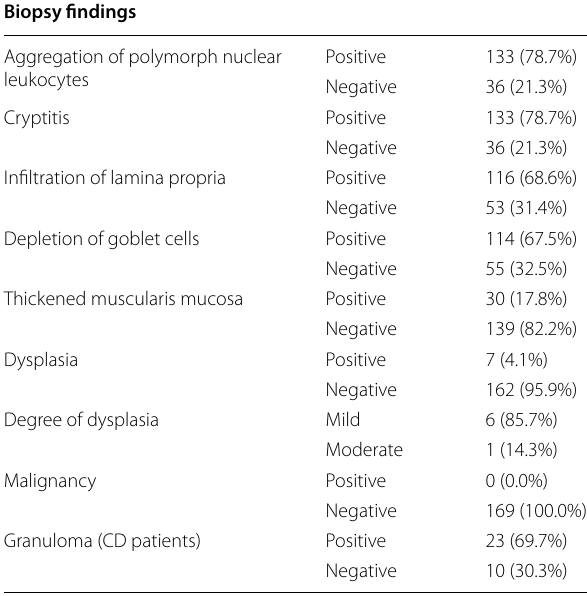
Table 8 Histopathological findings